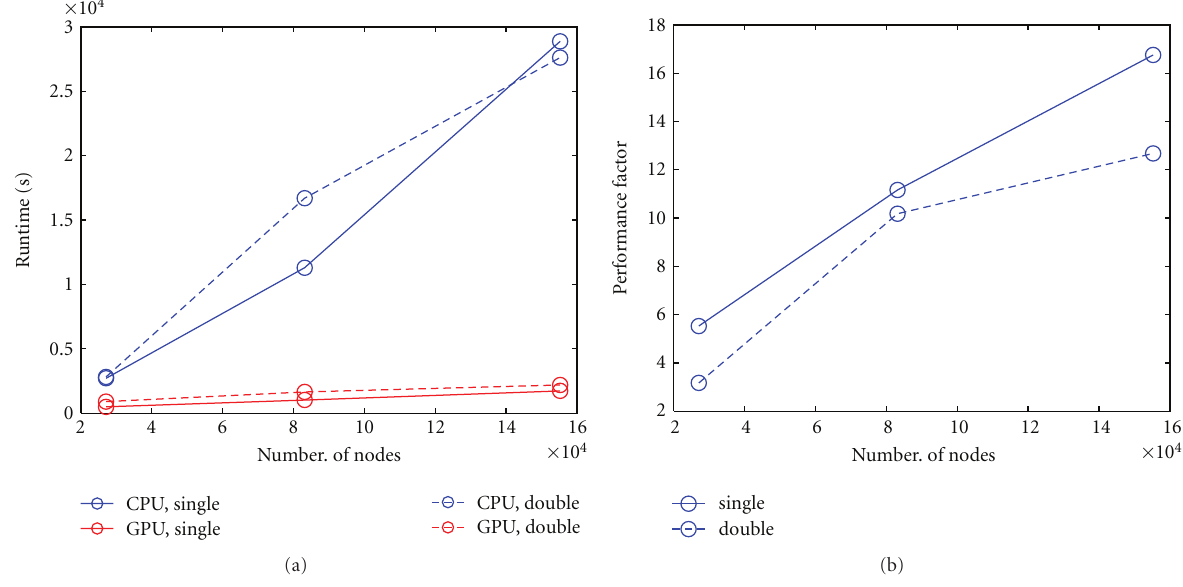
Figure 9: Run-time comparison for CPU and GPU forward solution of time-dependent FEM problem over 100 time steps. (a): Run-times for single and double precision arithmetic as a function of mesh complexity; (b): performance factors.